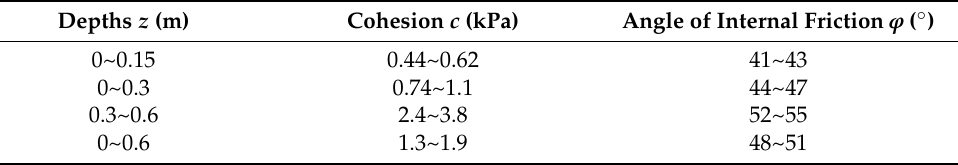
Table 1. Estimated values of cohesion and the angle of internal friction of the lunar regolith at different depths (Data from reference